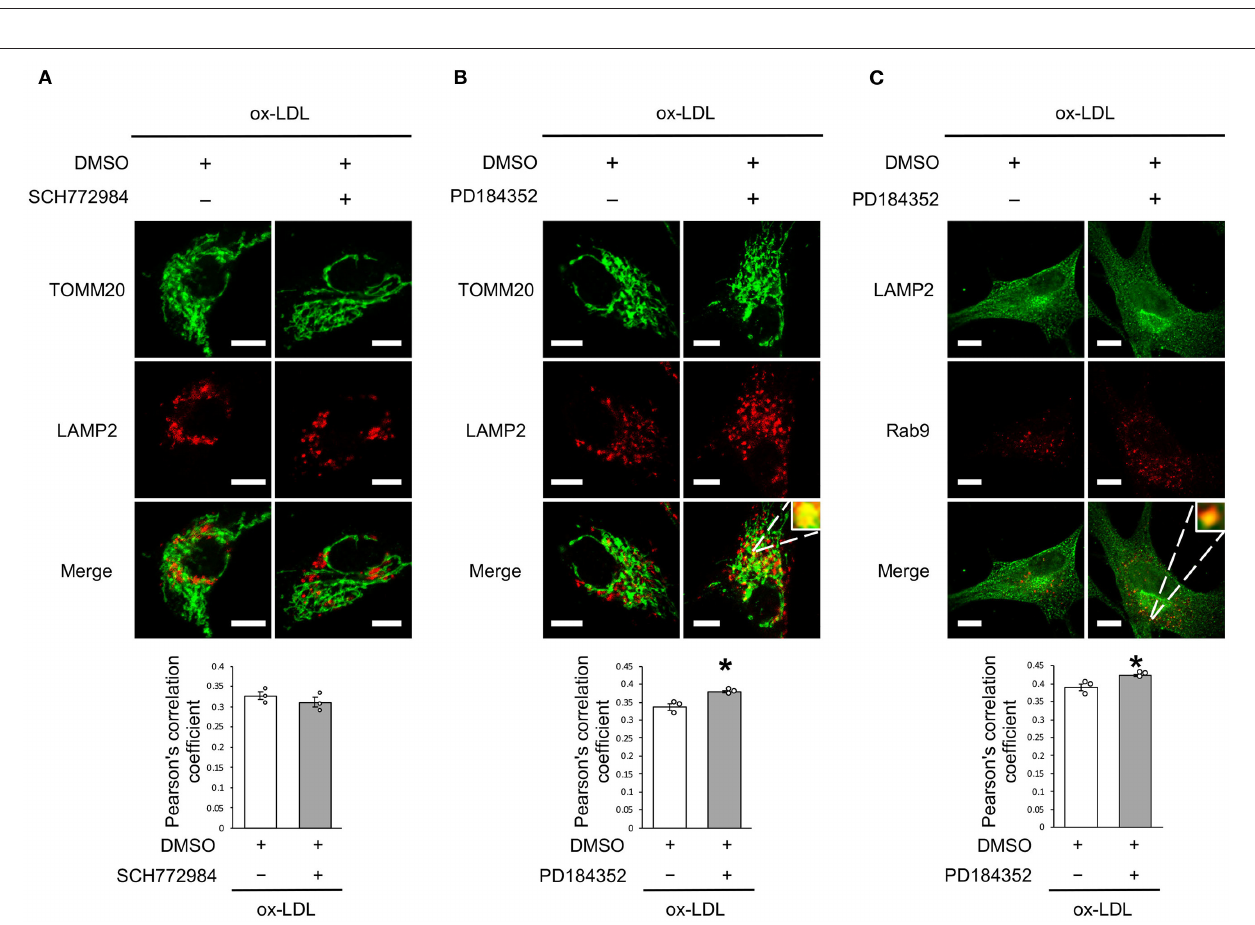
FIGURE 5 | ox-LDL with the control ( n = 15 per group). (B) Representative images and quantitative analysis of TOMM20 (green) and LAMP2 (red) immunohistochemistry in Candesartan-treated vs. control cells with ox-LDL. Scale bar = 10 µ m. * P < 0.05 vs. ox-LDL with the control ( n = 3 per group). (C) Representative images and quantitative analysis of LC3 (green) and LAMP2 (red) immunohistochemistry in Candesartan-treated vs. control vehicle-treated cells with ox-LDL ( n = 3 per group). Scale bar = 10 µ m. (D) Representative images and quantitative analysis of LAMP2 (green) and Rab9 (red) immunohistochemistry in Candesartan-treated vs. control cells with ox-LDL. Scale bar = 10 µ m. * P < 0.05 vs. ox-LDL with the control ( n = 3 per group). (E) Representative images and quantitative analysis of TOMM20 (green) and LAMP2 (red) immunohistochemistry in Candesartan-treated vs. control cells transfected with siRab9 under ox-LDL treatment. Scale bar = 10 µ m. ( n = 3 per group). (F) Representative images and quantitative analysis of TOMM20 (green) and LAMP2 (red) immunohistochemistry in Candesartan-treated vs. control cells transfected with si Atg7 under ox-LDL treatment. Scale bar = 10 µ m. * P < 0.05 when compared with control vehicle-treated cells transfected with si Atg7 under ox-LDL treatment ( n = 3 per group). All data are presented as the mean ± SEM. Statistical analysis were conducted by Wilcoxon rank sum test (B,C,E,F) and Student’s t -test (A) .